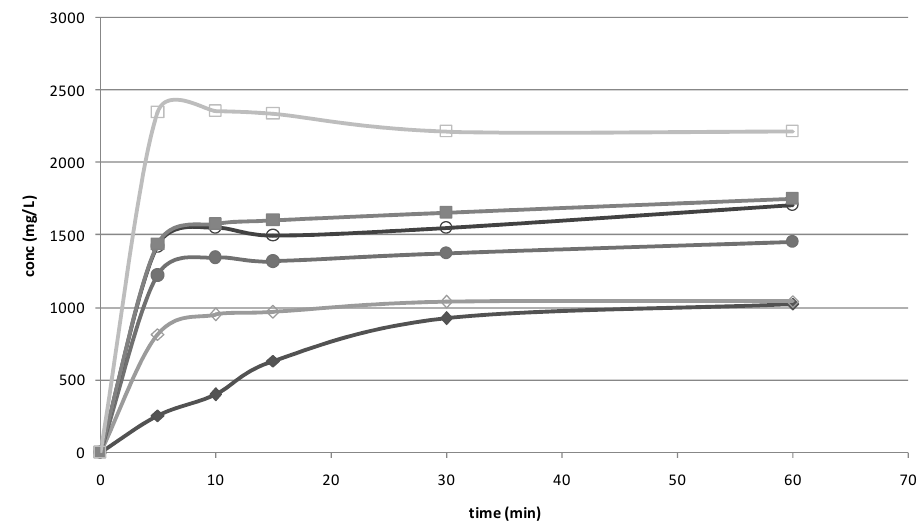
Figure 1. Dissolution rate studies performed with HCT alone ( (cid:7) ), HCT ground ( ♦ ) and the binary systems with HP β CD (P.M. ● ; GR ○ ) and SBE β CD (P.M. ■ ; GR □ ).